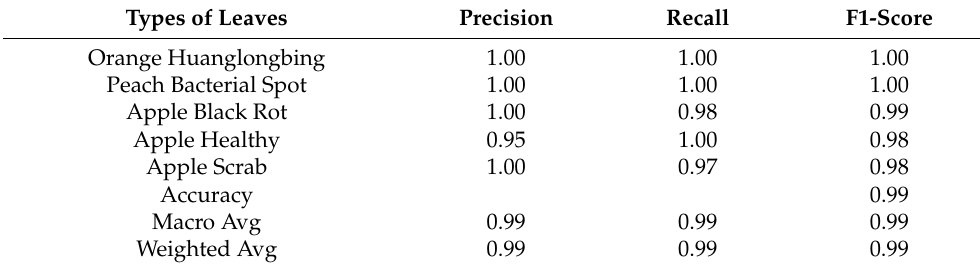
Table 2. Evaluation metrics of Top-5 leaves. Types of Leaves Precision Recall